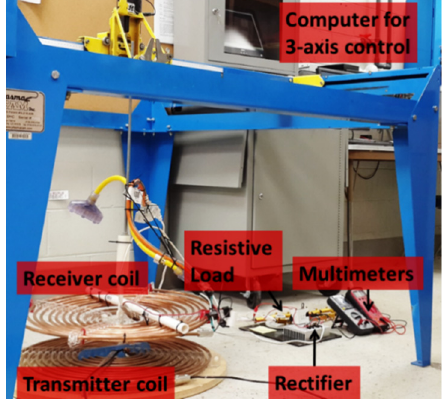
Figure 6. Experimental setup for misalignment